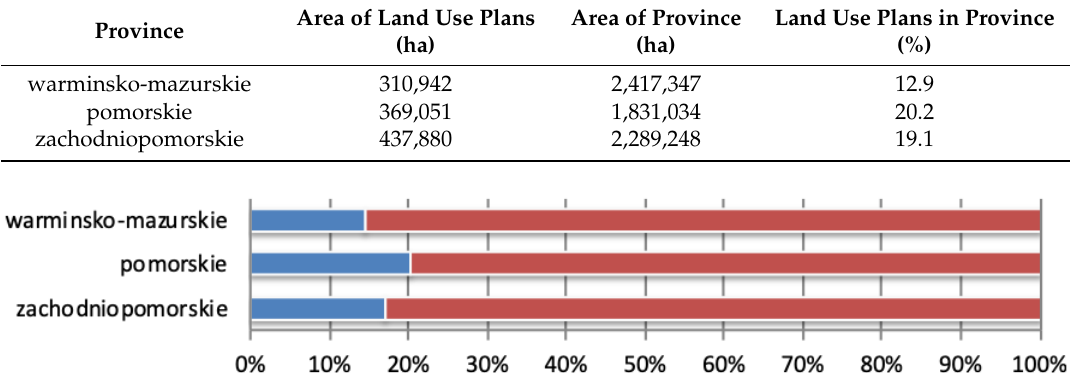
Figure 8. Local land use plans in the municipalities. Source: prepared by the author based on State Register of Borders and [55]